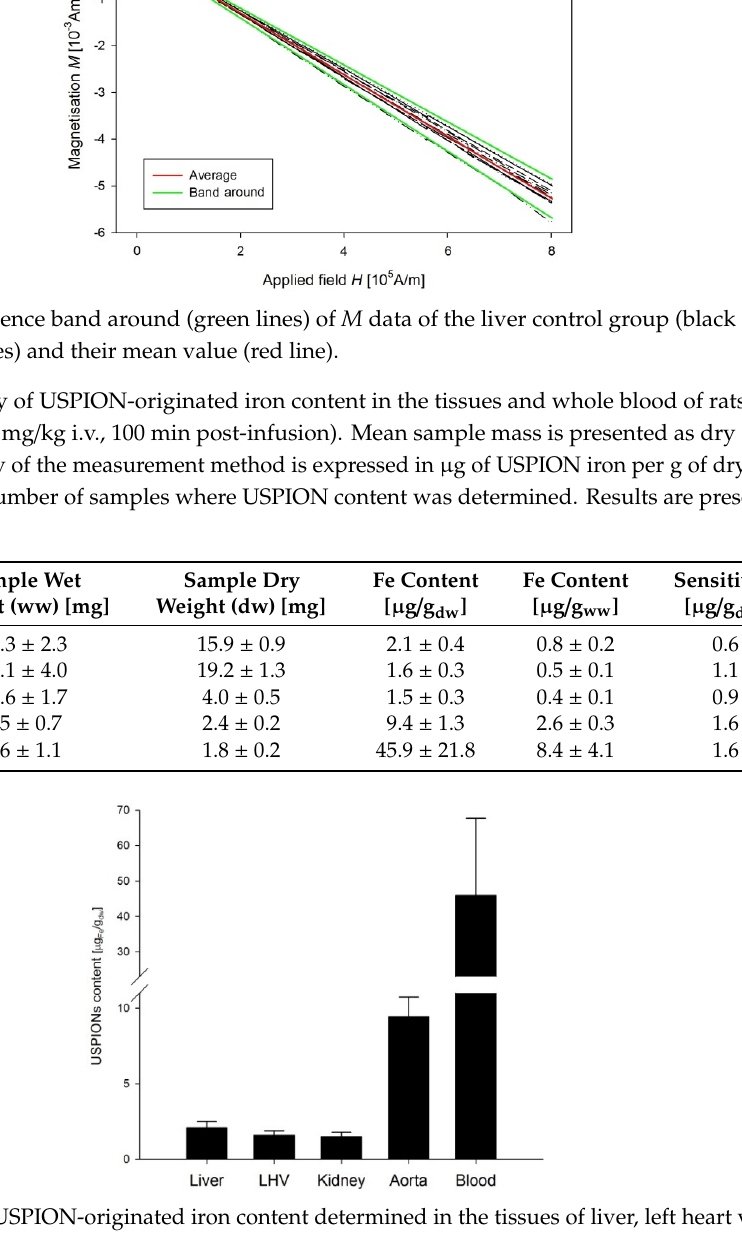
𝑦(cid:3548) and 𝜎(cid:3548) were